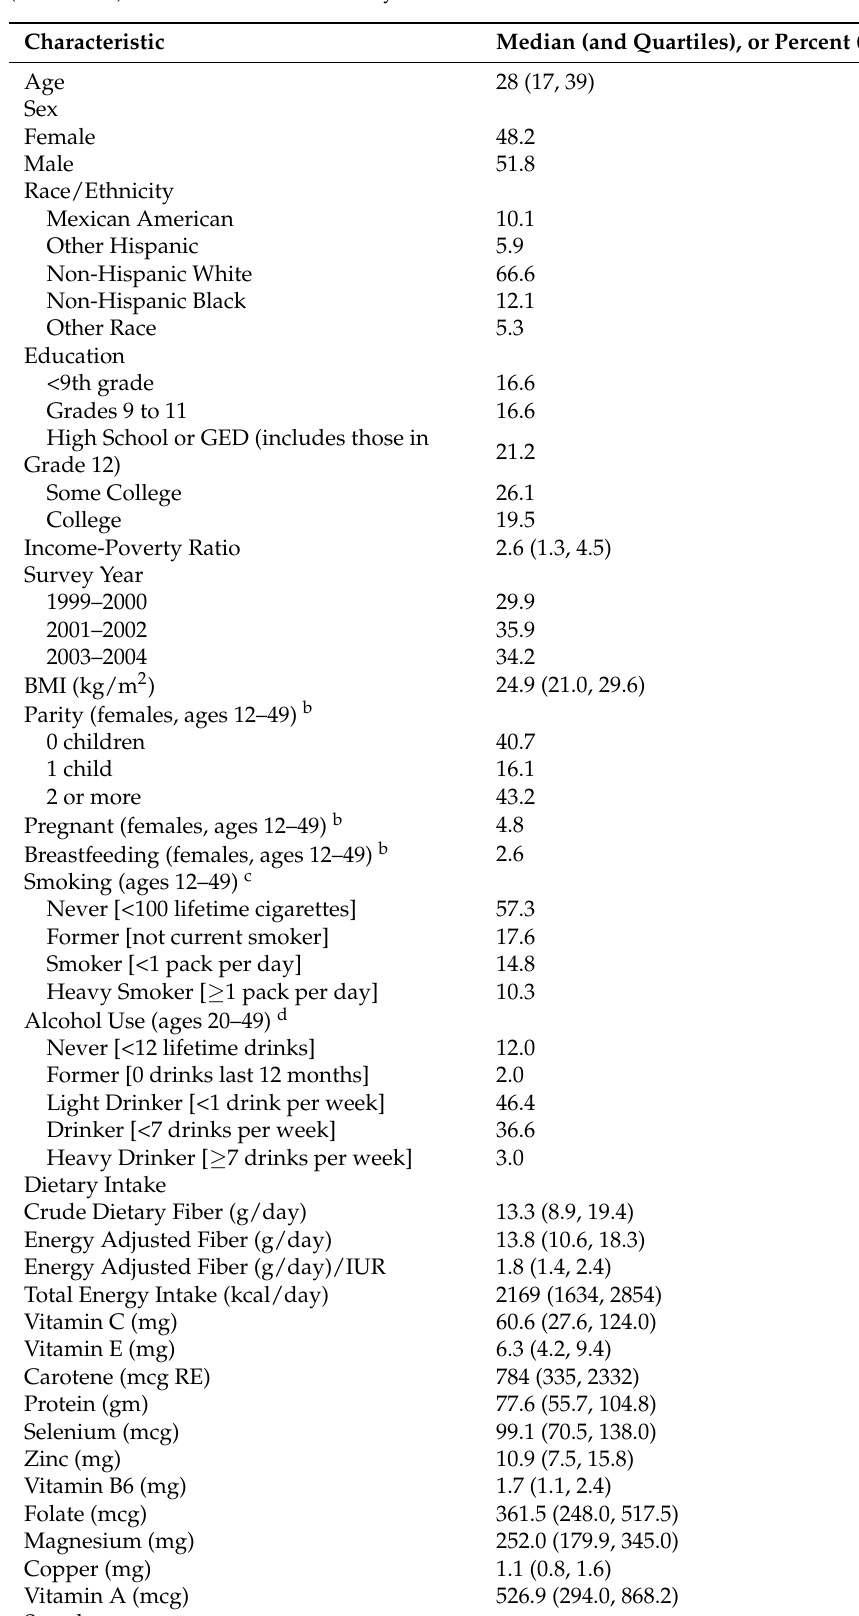
Table 1. Characteristics of National Health and Nutrition Examination Survey (NHANES) subjects (1999–2004) included in the main analyses a